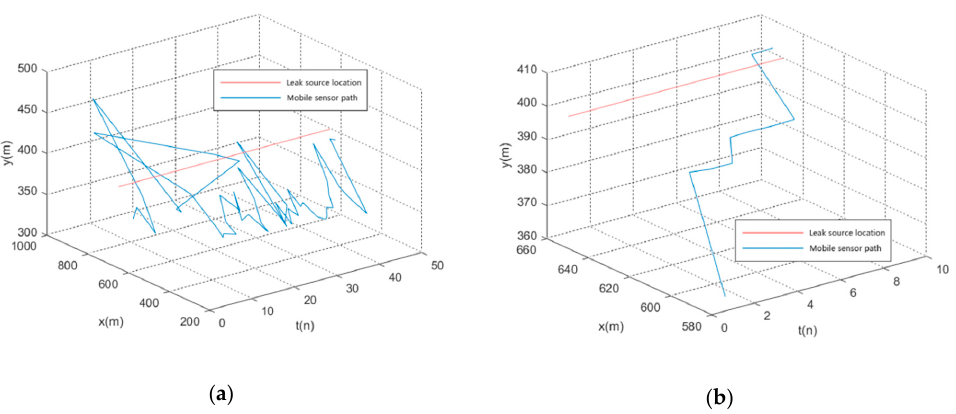
Figure 9. Mobile sensor moving steps ( a ) before introducing the optimization result memory; and ( b ) after introducing the optimization result memory.